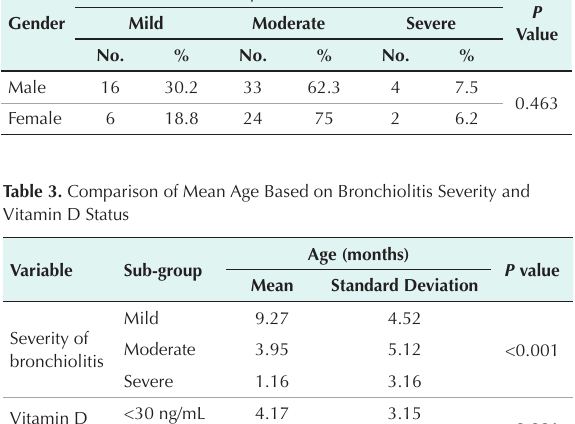
Table 2. The Relationship Between Gender and Severity of Bronchiolitis Severity of Bronchiolitis Gender ValueMild Moderate Severe